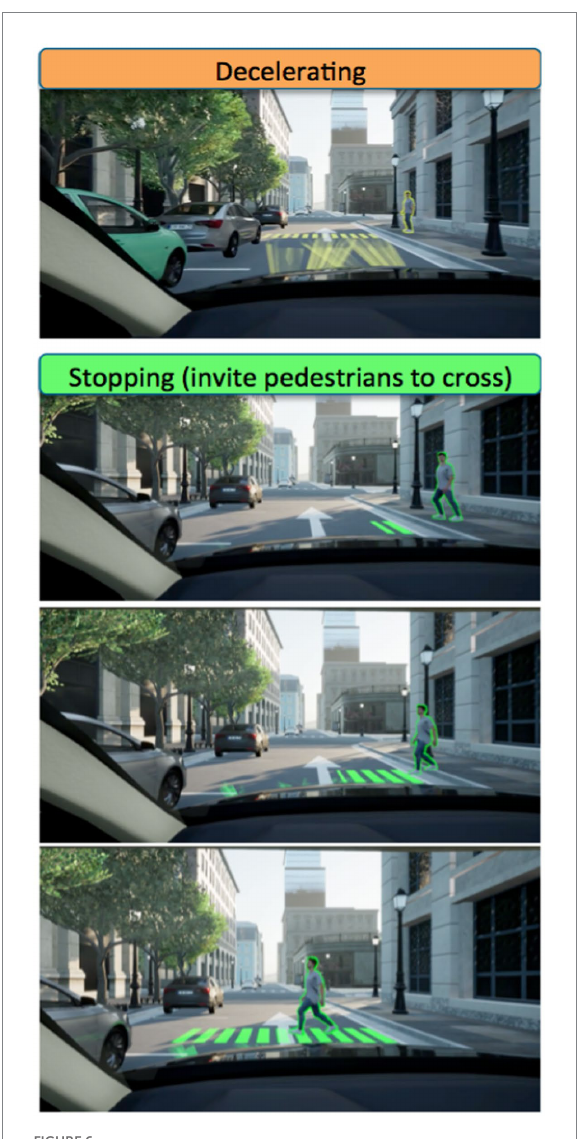
FIGURE 6 The eHMI, from the AV passenger’s point of